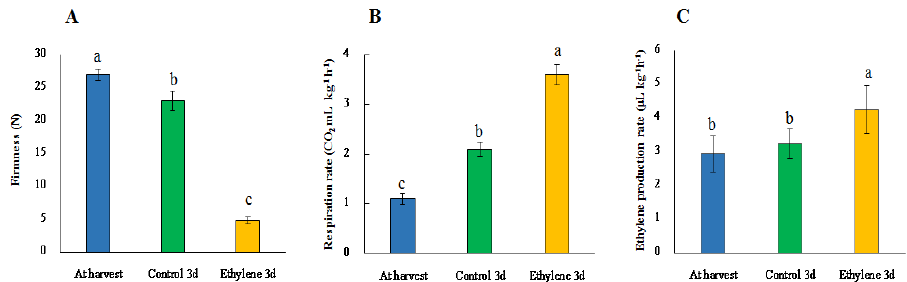
Figure 5. Firmness ( A ), respiration rate ( B ) and ethylene production rate ( C ) of ‘Haegeum’ gold kiwifruit as affected by ethylene treatment during 3 days of ripening at 25 °C. Vertical bars represent standard errors of the means ( n = 15). Different letters indicate significant difference between different groups by Tukey’s test at p ≤ 0.05. Table 4. List of DEGs in ‘Haegeum’ gold kiwifruit (upregulated) in the comparison of ethylene treated vs.